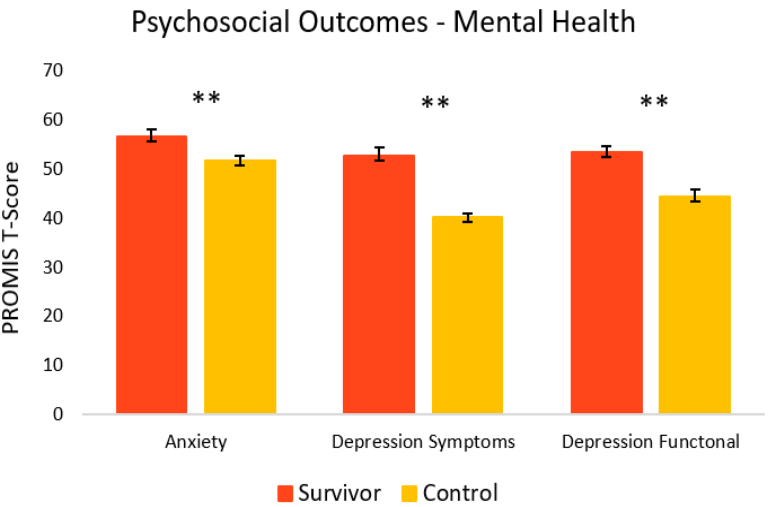
Figure 4. Psychosocial mental health-related outcomes in cancer survivors and healthy controls. Group means are presented. Error bars represent standard error of the mean (SEM). Significance is denoted by ** at the p < 0.01 level. Group n = 17–18.